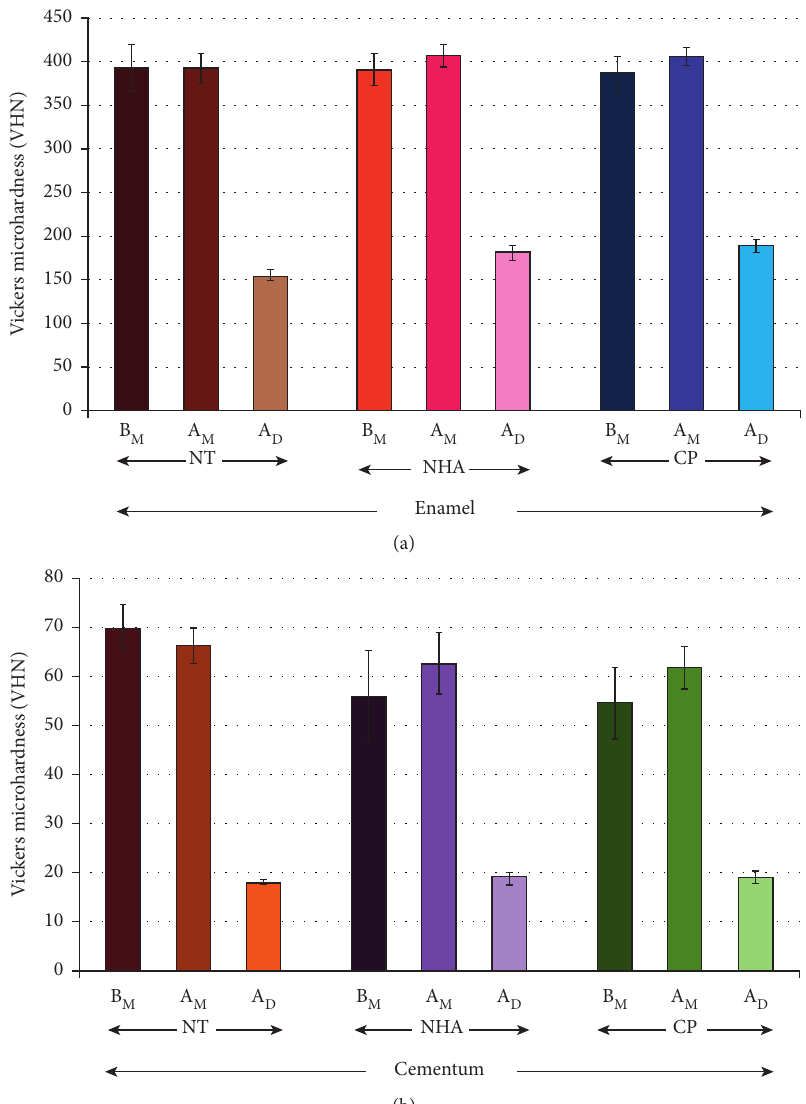
Figure 3: The mean and standard deviation (SD) of Vickers microhardness (VHN) of enamel (a) and cementum (b) before material application ( B M ), after material application ( A M ), and after inducing demineralization ( A D ) with nanohydroxyapatite (NHA) and Clinpro (CP), in comparison with no treatment